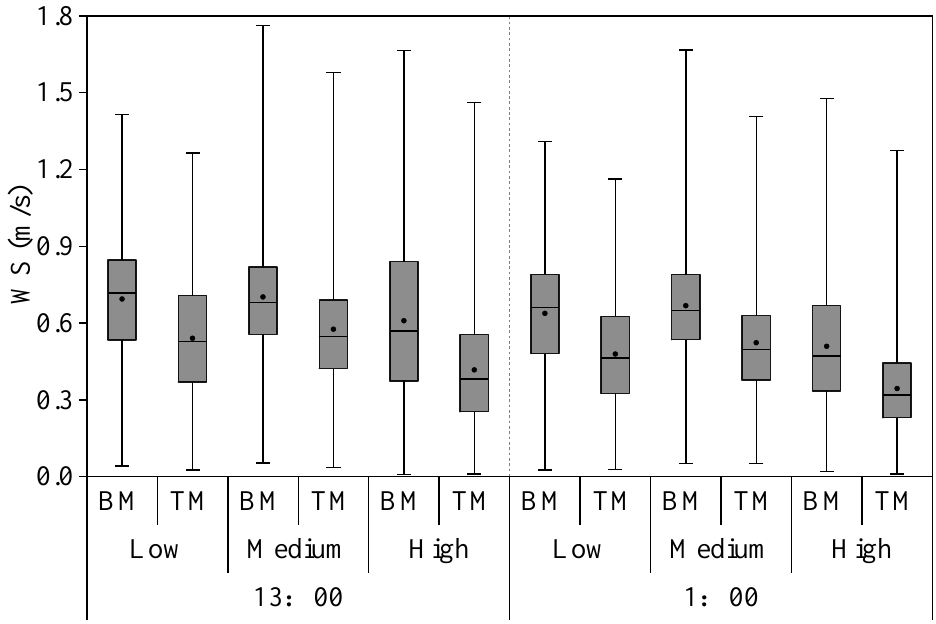
Figure 6. WS in BM and TM in all three types of districts at 13:00 and 1:00 pm.